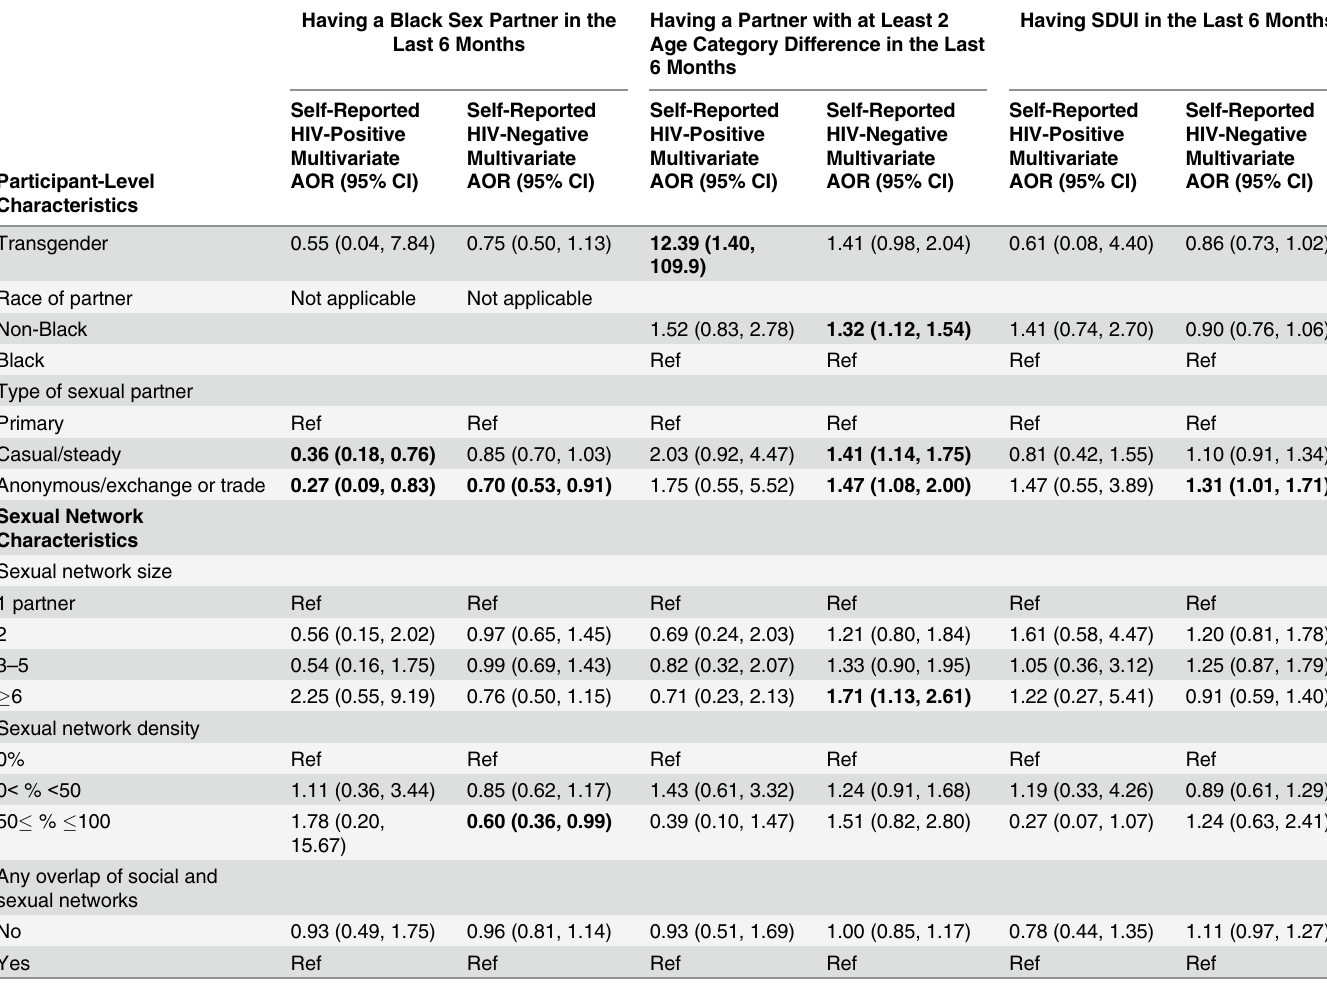
The odds of having a partner with at least two age category difference among HIV-positive men were higher with having a transgender partner vs. male partner. The odds of having a partner with at least two age category difference among HIV-negative men were higher with having a non-Black partner, having a non-primary partner vs. primary partner, and having a sexual network size (cid:3) 6 vs. 1 partner. The odds of having SDUI in the last six months among HIV-positive participants were higher with having depression and having a partner between 21 – 40 years of age vs. > 40 years. Among HIV-negative men, the odds of SDUI were lower with younger age, while higher for those having less than a college degree, any drug/alcohol use before unprotected sex in the last six months, and having an anonymous/exchange or trade partner vs. primary